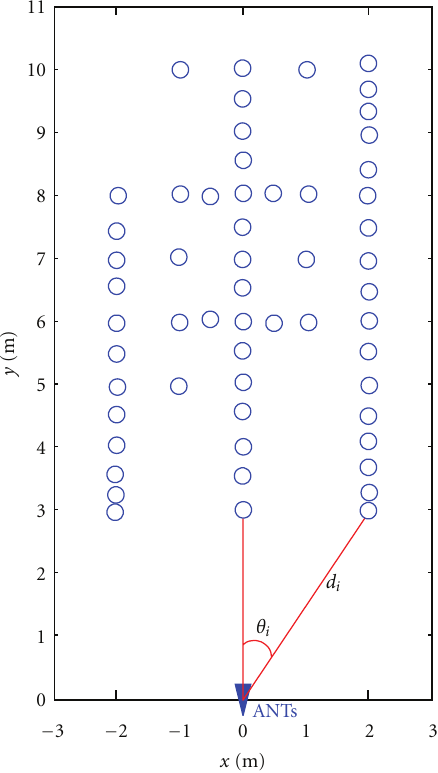
Figure 9: 57 locations of a target vehicle in outdoor